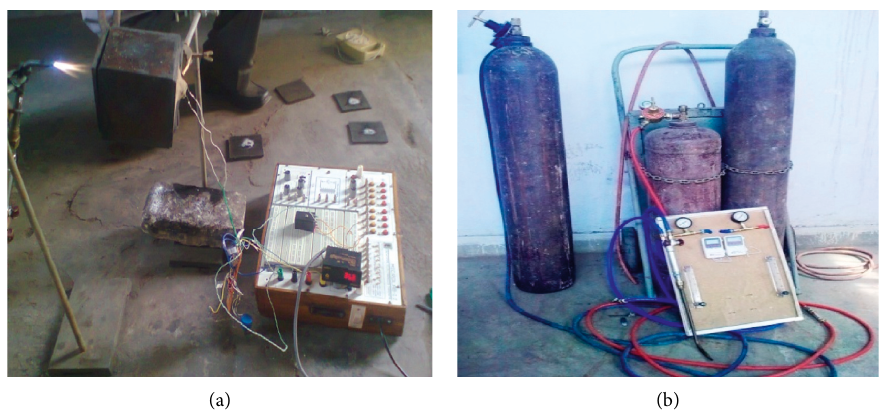
Figure 3: (a) Assemblies of oxyacetylene flame apparatus and (b) timer electronic circuit.